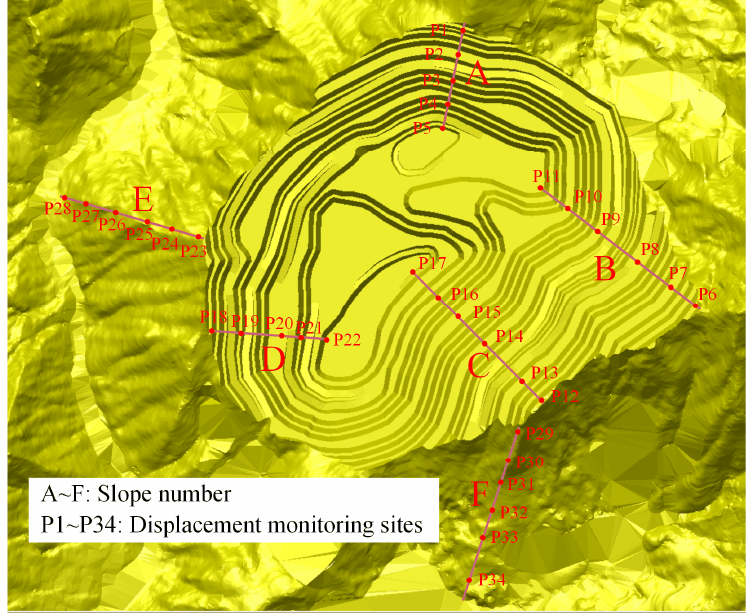
Figure 11. The locations of the open-pit boundary slope displacement monitoring